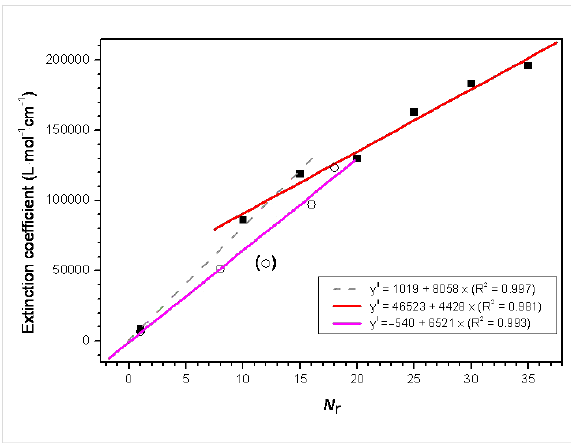
Figure 4: Extinction coefficient for the macrocycles of series I (circles) and II (squares) versus the number of thiophenes including the corres- ponding least-squares fit (y I and y II ) for the fit function ε = a + b N r . Compound C12T (circle in parentheses) was not included in the linear fit of series